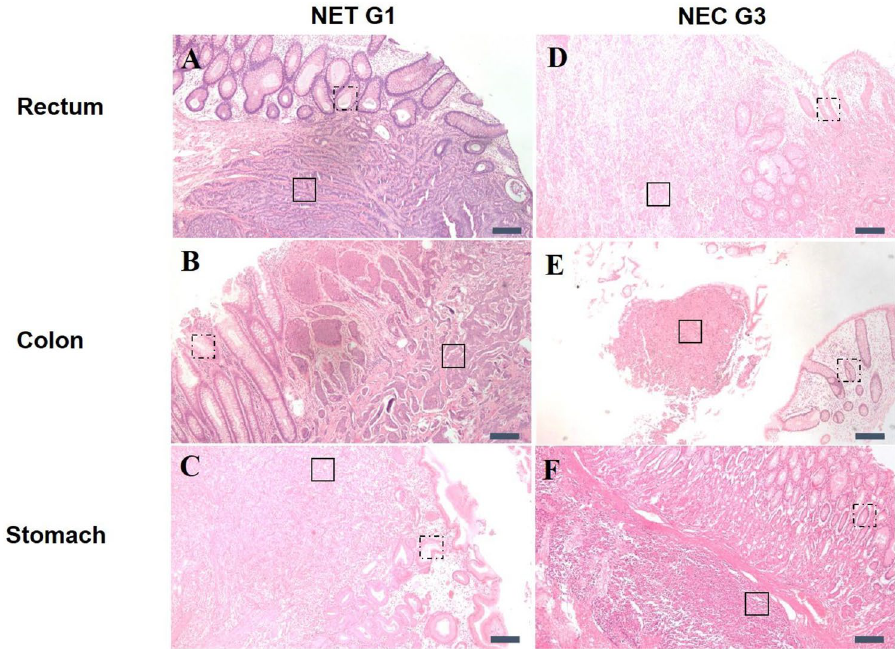
Figure 2. Representative findings of tumor (solid line) and adjacent normal mucosa (dotted line) of NET ( A – C ) and NEC ( D – F ) in histological sections. The scale bar indicates 200